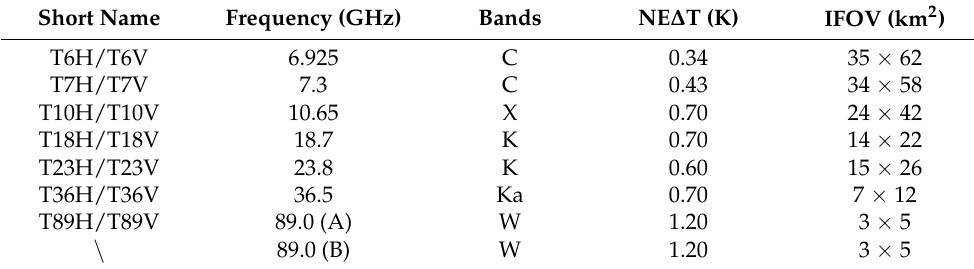
Table 1. Channel characteristics of the Advanced Microwave Scanning Radiometer 2 (AMSR2) [28]. Each observation frequency has vertical (V) and horizontal (H) polarizations. The measuring range of each channel is 2.7 − 340 K. NE ∆ T: noise equivalent differential temperature; IFOV: instantaneous field of